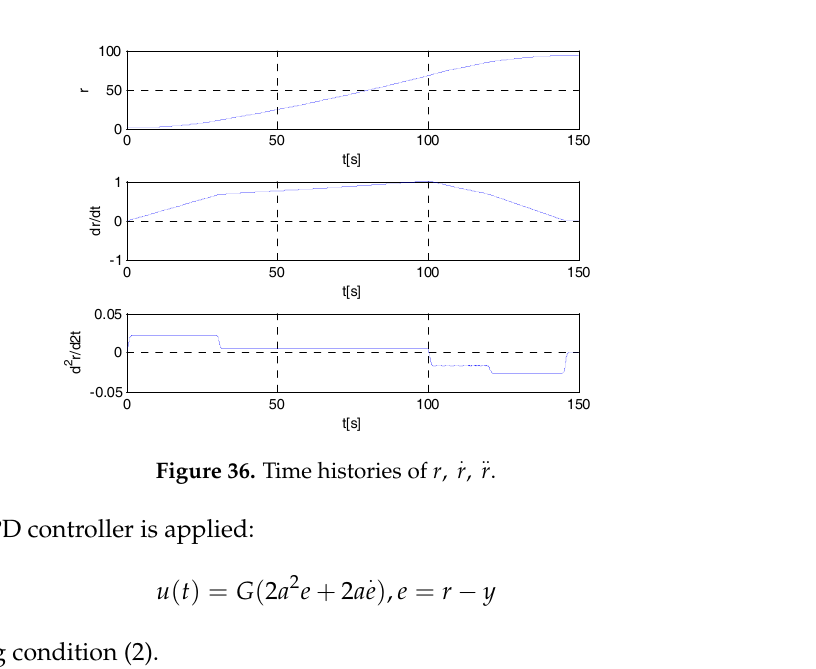
Figure 36. Time histories of , , r r r   .